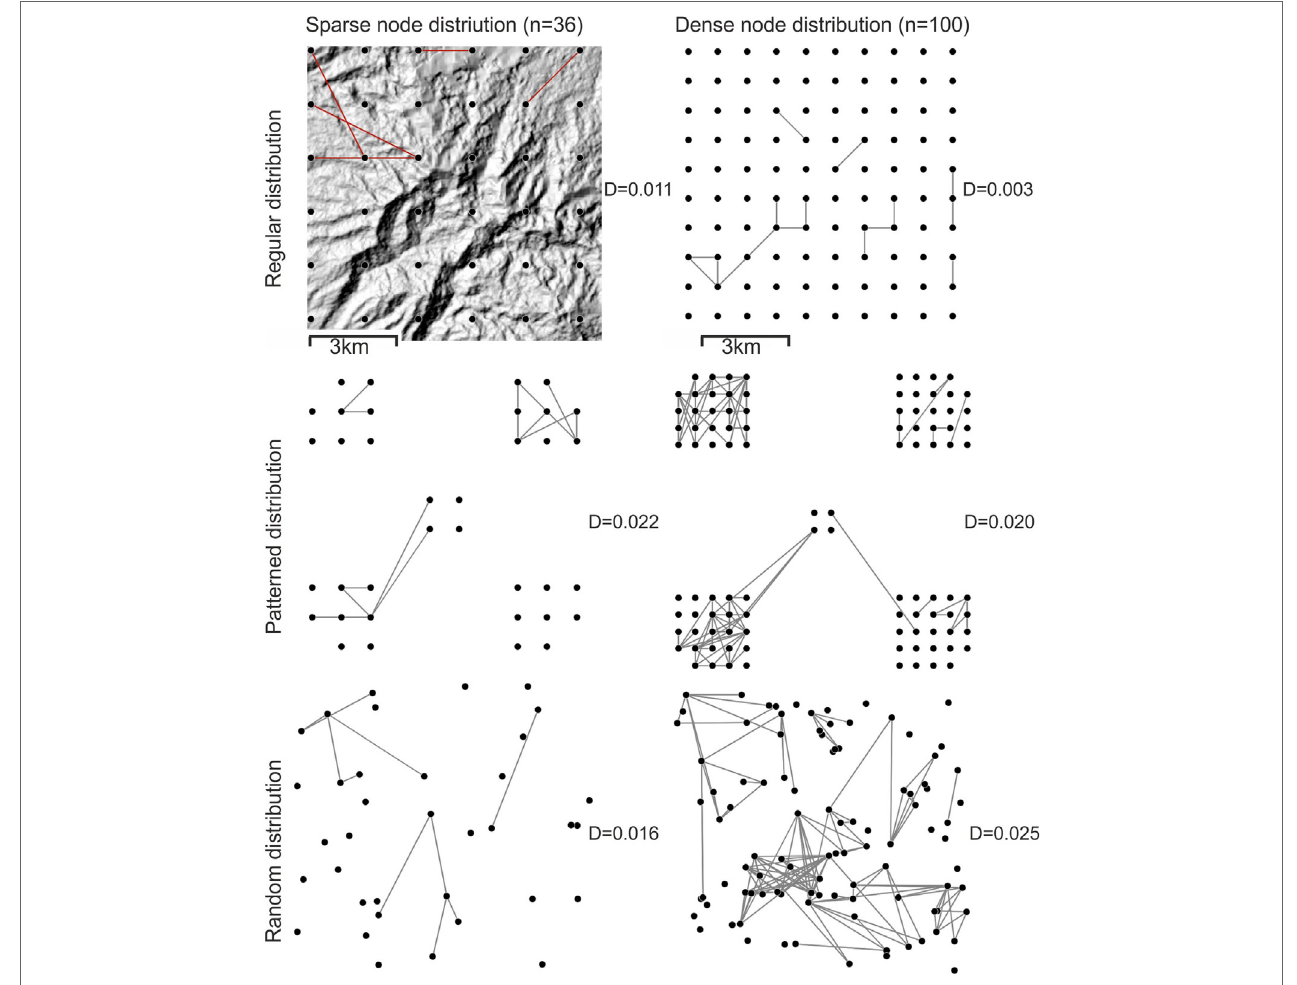
FigUre 8 | Densities (D) of visibility networks between differently distributed observation locations in a mountainous landscape (Basse-Terre in Guadeloupe, French West Indies) of 9 km by 9